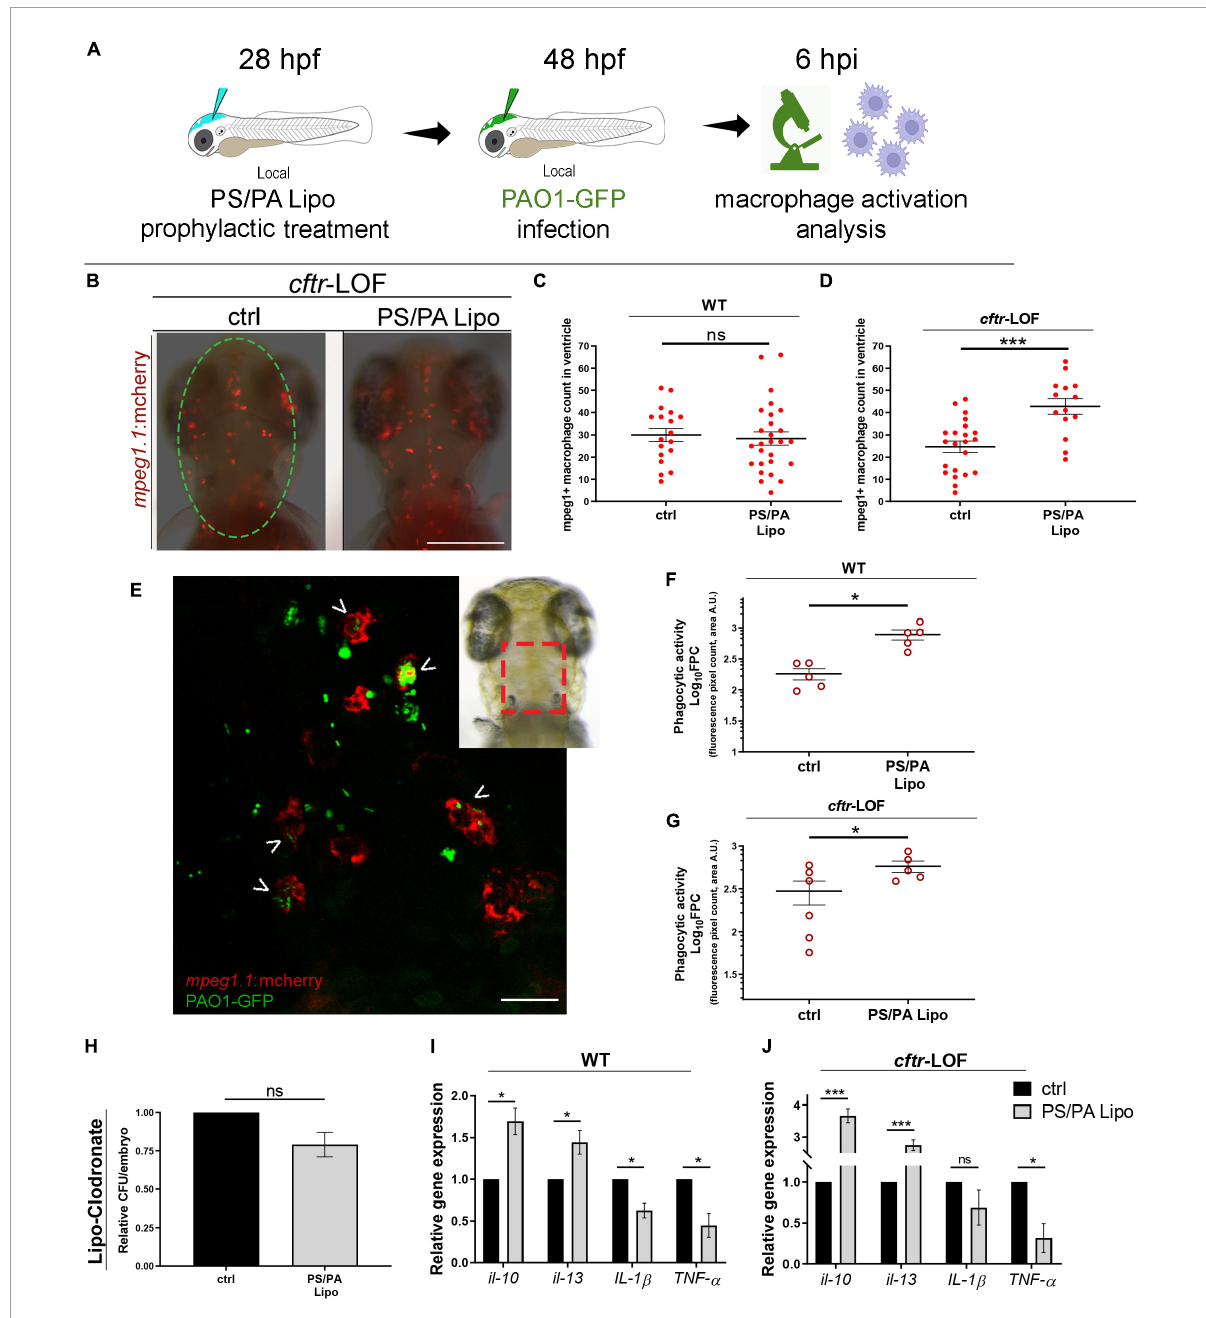
FIGURE2 Macrophage activation in wild-type (WT) and cftr -LOF zebrafish embryos upon phosphatidylserine/phosphatidic acid (PS/PA) liposome prophylactic administration. (A) Schematic representation of PS/PA liposome prophylactic treatment. Zebrafish embryos were treated with PS/PA liposome at 28 hpf, then locally infected with PAO-GFP at 48 hpf and analyzed for macrophage activation at 6 h post infection. (B) Representative image of macrophage migration toward the PAO1-GFP bacteria injected in the hindbrain ventricle (circle area) of ctrl or PS/PA liposome treated cftr -LOF embryos. (C,D) Quantification of mpeg1 :mcherry positive macrophages in the selected area of the ventricle of ctrl or PS/PA liposome treated WT (C) or cftr -LOF embryos (D) . (E) Representative image of red macrophages of the Tg ( mpeg1:mcherry ) embryos phagocyting PAO1-GFP bacteria (arrowheads), injected in the hindbrain ventricle (visual imaging in the right-upper box). (F,G) Quantitative analysis (Log 10 fluorescence pixel count, related to colocalization area) of phagocytic activity of macrophages against PAO1-GFP bacteria in WT (F) and cftr -LOF embryos (G) , control (ctrl) and PS/PA liposome treated. (H,I) Pro- and anti-inflammatory cytokines expression by RT-qPCR analyses at 20 hpi in WT (I) and cftr -LOF embryos (J) , ctrl and PS/PA liposome treated embryos, systemically infected with PAO1. (J) Bacterial load quantification (relative CFU/embryo) at 8 hpi in ctrl and PS/PA liposome treated WT embryos treated with Lipo-clodronate. Unpaired Student’s t test: *** p < 0.001; * p < 0.05; ns: not significant. Data resulted from at least two (C,D,F,G) or three (H–J) independent experiments and results are presented as mean ± SEM. Scale bar indicates 200 µ m in panel (B) 20 µ m in panel (E)